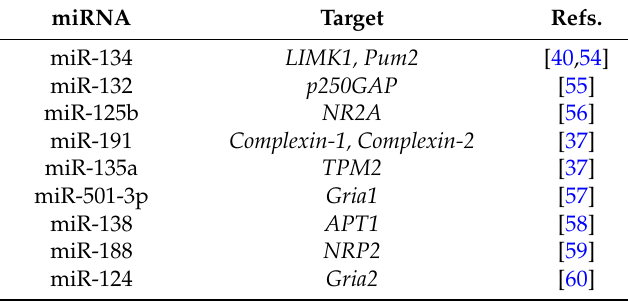
Table 1. miRNAs involved in synaptic plasticity. miRNAs are important regulators of neuronal translation in the soma and within dendritic spines and synapses. This table summarizes key miRNAs identified within neuronal dendrites that have been identified to be major regulators in synaptic